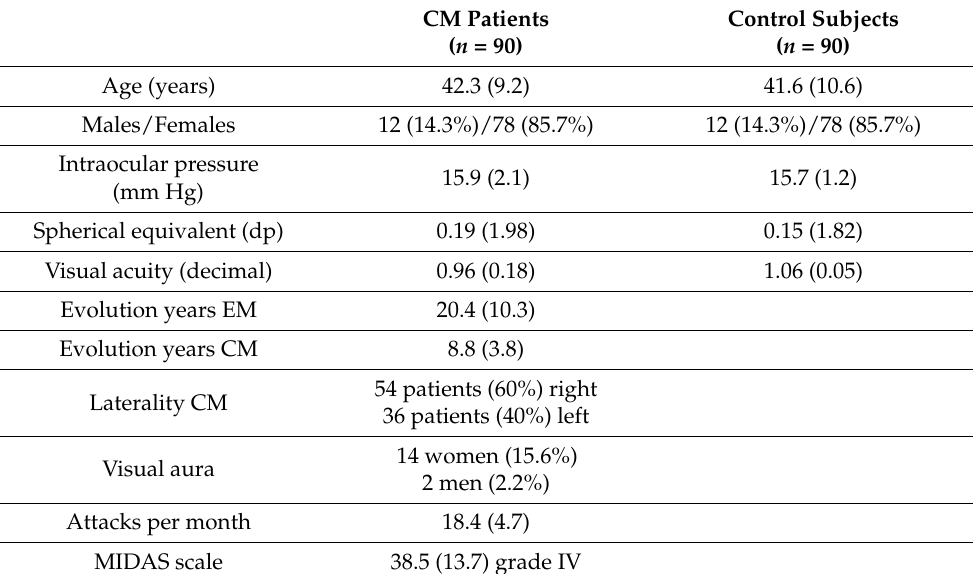
Table 1. Socio-demographic and clinical data of the CM patients and control